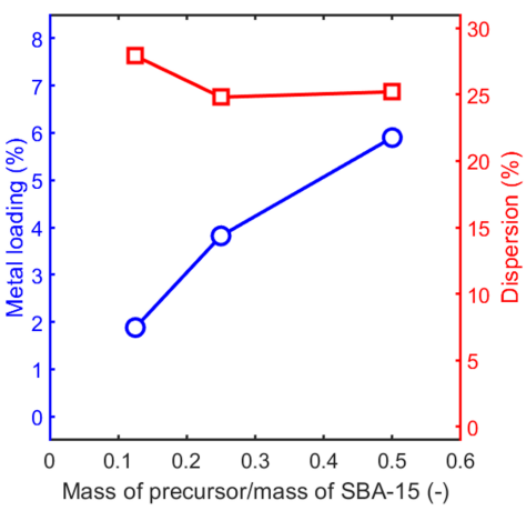
Figure 3. Representative TEM images of (a) Pd/SBA-15(low) and (b) Pd/SBA-15. Figure 4. Pd loadings and dispersions versus the ratio of the mass of the precursor to the mass of the SBA-15.